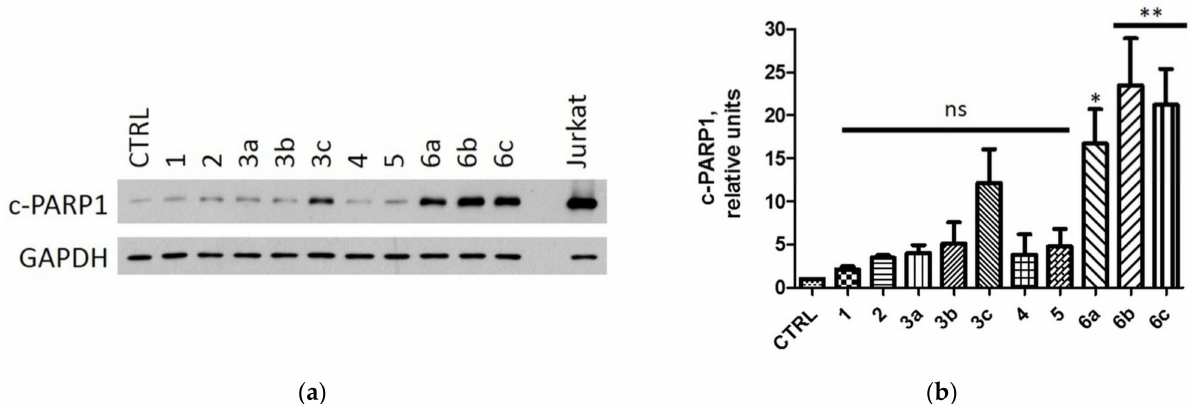
Figure 8. Effect of compounds 1 , 2 , 3a – c , 4 , 5 and 6a – c on the level of cleaved PARP1 (c-PARP1) in MCF-7 cells. MCF-7 cells were treated with compounds 1 , 2 , 3a – c , 4 , 5 and 6a – c used in the concentrations corresponding to their EC 50 values for 72 h, and subsequently, the respective extracts were subjected to Western blot analysis (see “Western Blotting”). GAPDH was used as a protein loading control for each sample. ( a ) The representative blots. UV-irradiated Jurkat cells were used as a positive control (see “Western Blotting”). ( b ) Densitometry analysis for c-PARP1. Untreated cells served as the reference point (one relative unit). Graphs represent mean values ± s.e.m. * p < 0.05, ** p < 0.01 relative to control; ns—not